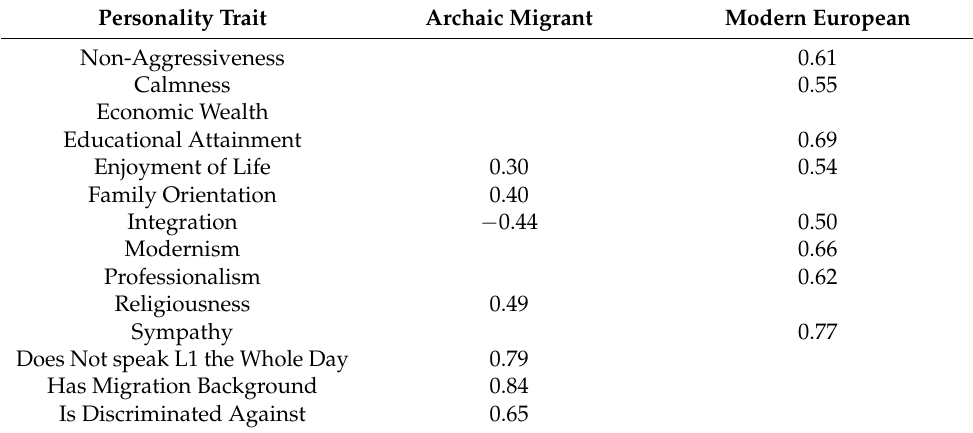
Table 6. Exploratory Factor Analysis: Two-Factor Model 1 . Personality